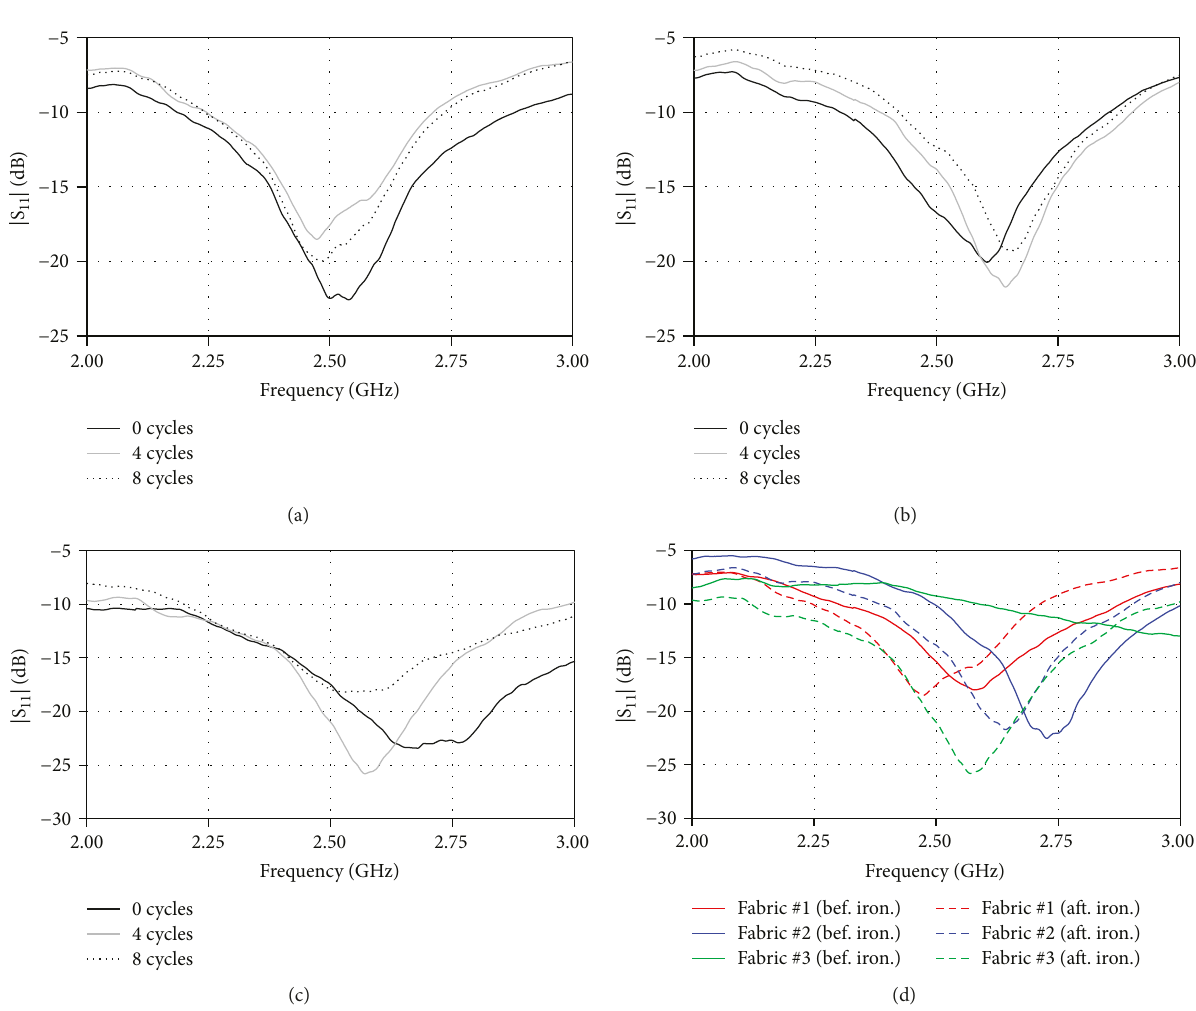
Figure 8: Results of the durability test performed on the prototypes shown in Figure 5: (a) prototype fabricated exploiting Fabric #1; (b) Fabric #2-based prototype; (c) prototype based on the use of the Fabric #3; (d) e ff ects of the feed-line unsticking on the antenna frequency behavior. Table 2: Comparison between gain measured at 2.5GHz before and after the durability tests. Max. gain Prototype (with the re fl ector)